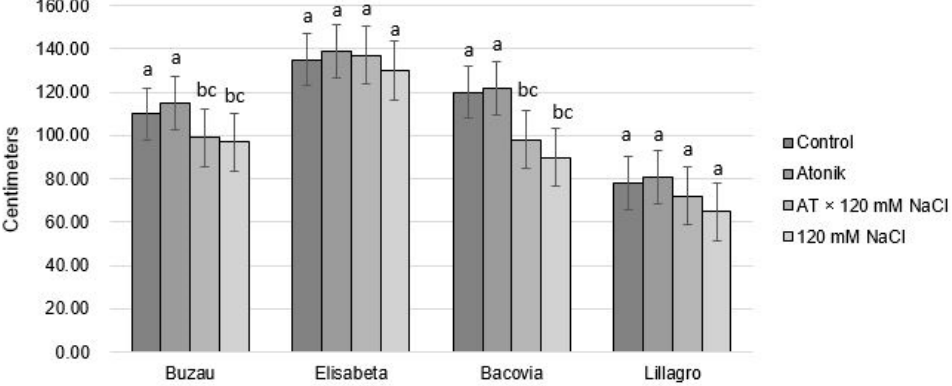
Figure 3. The effect of Atonik biostimulant on the height of tomato plants under saline stress after the third treatment. Different letters mean significant differences, according to the Tukey test. Error bars indicate ±SD. The average number of flowers per plant was affected by salt stress in all four tomato cultivars studied. In the Buzau variety, significant differences were recorded between the control variant and the 120 mM NaCl variant and between the Atonik variant and the 120 mM batch, as well as between AT × 120 mM NaCl and 120 mM NaCl (Figure 4).